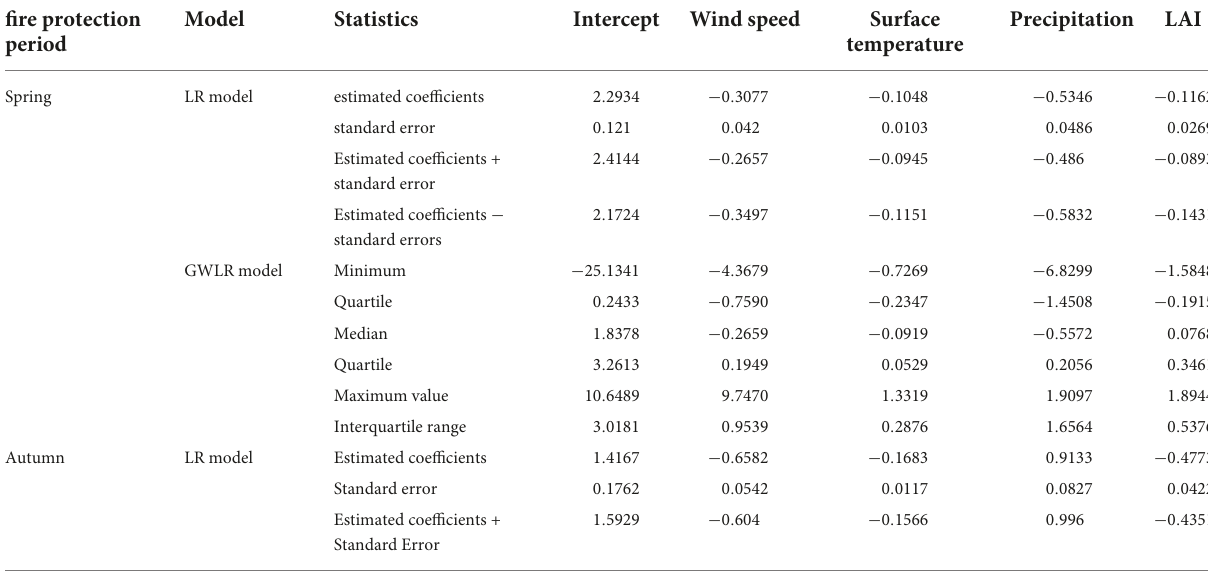
APPENDIX TABLE 2 Spatial stationarity evaluation of parameter estimation for the geographically weighted logistic regression (GWLR)